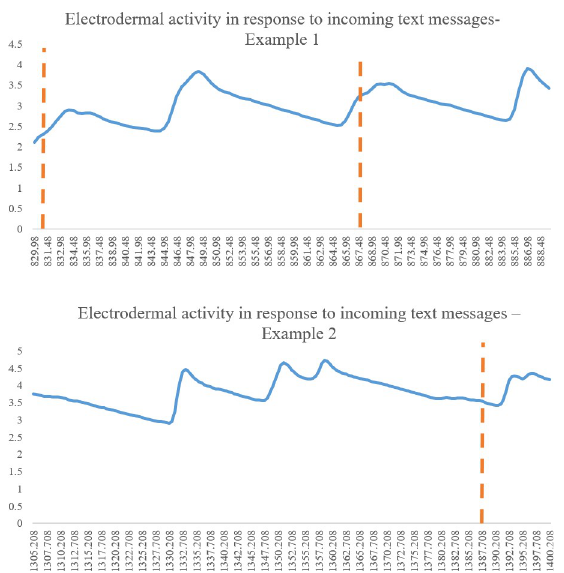
Fig 4. Two examples of changes in EDA during the smartphone use condition. The top and bottom panels depict examples of electrodermal activity (EDA) from two mothers who participated in the study during the smartphone use conditions. These figures illustrate skin conductance responses (SCRs). The red vertical dotted lines indicate an incoming text message, which was followed by the mother’s required shift of attention to her phone in order to respond. The Y axis represents electrodermal activity in microsiemens, and the X axis represents elapsed time. As can be seen, it seems, at least descriptively, that incoming messages can be followed by a distinctive skin conductance